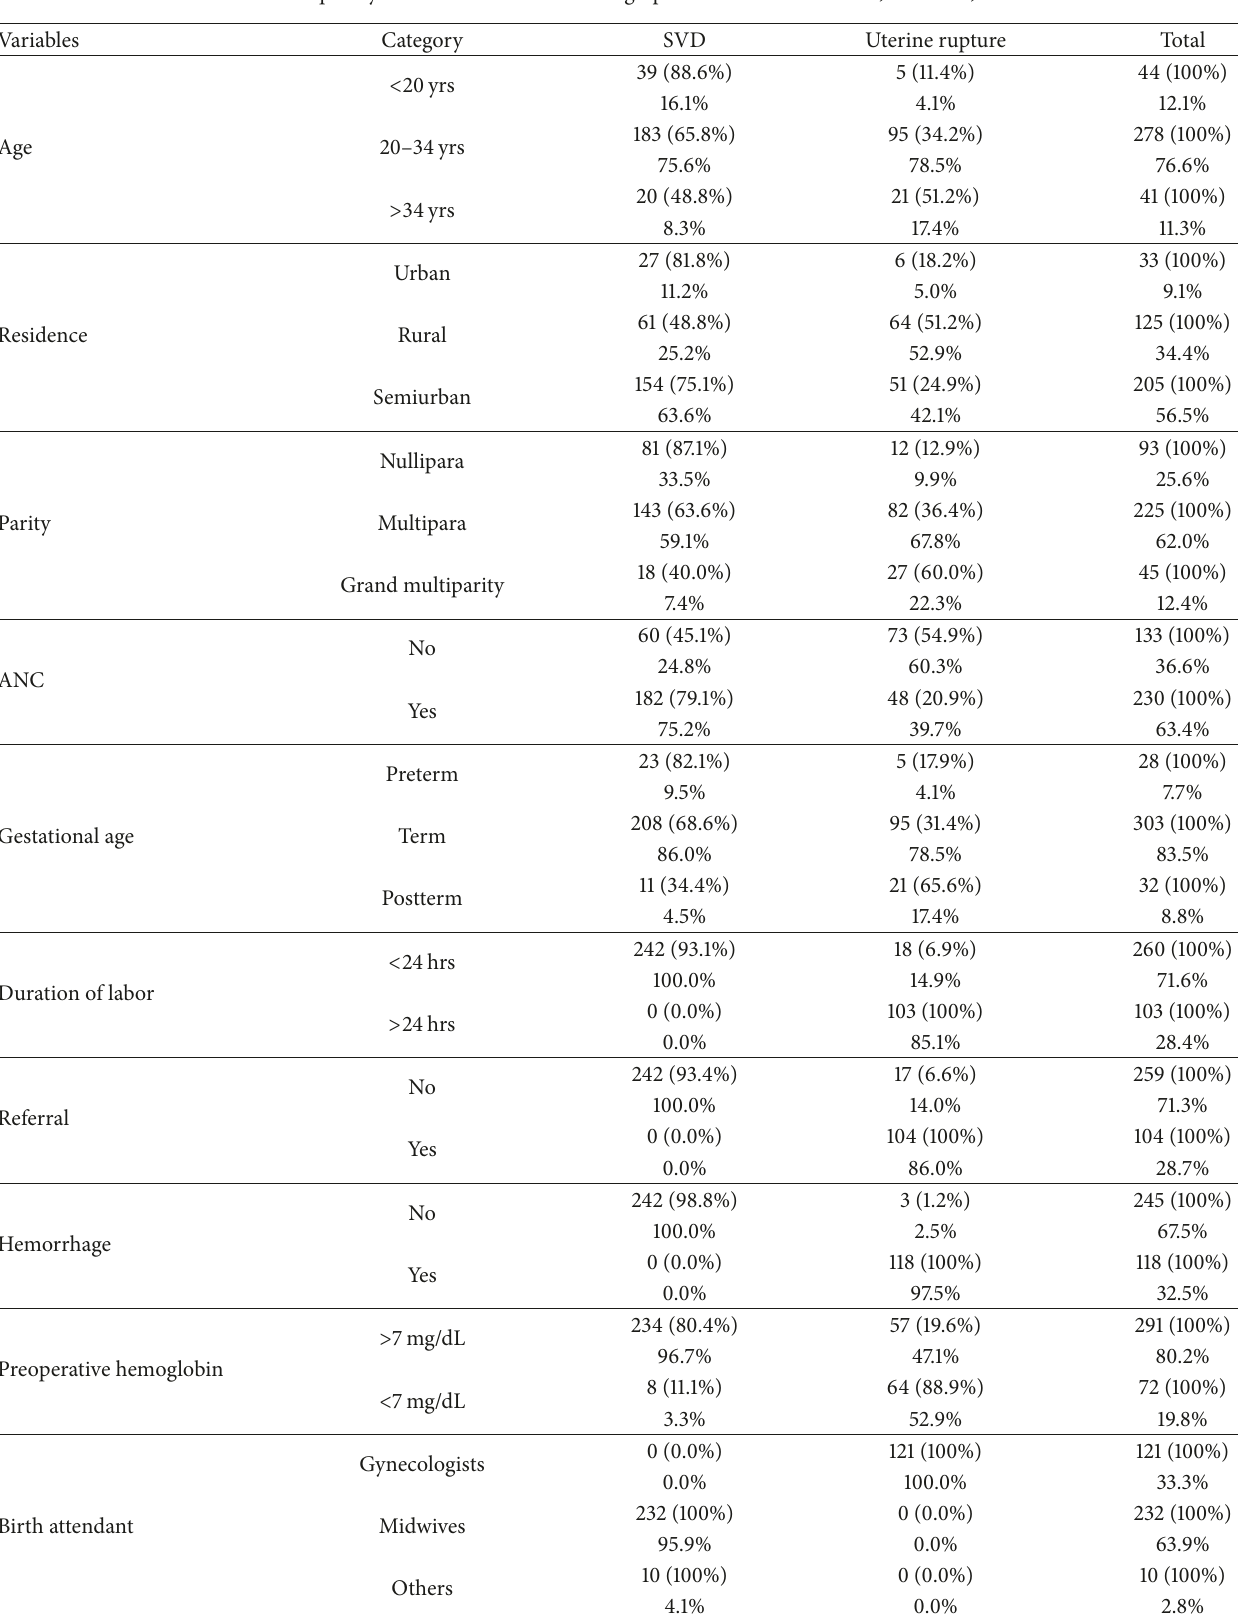
Table 1: Frequency distributions of sociodemographic and obstetric factors, MTUTH,